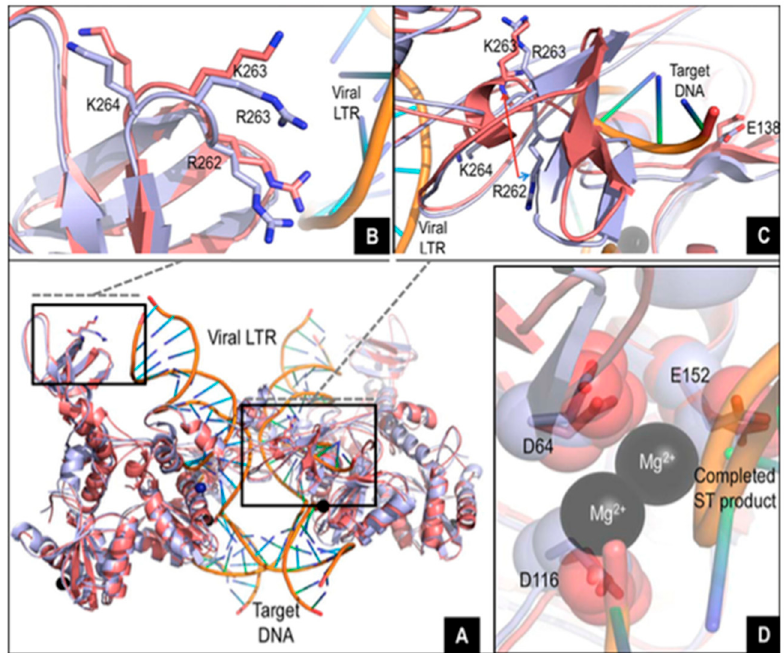
Figure 1. In silico studies of the wild-type and R263K integrases ( A – D ) adapted from Figure 4 of reference [2]. Overlay of the wild-type and R263K integrases, intasome and strand transfer complex models with viral LTR DNA and target DNA. The tetrameric IN structure is composed of the inner and outer subunits; ( B ) Detailed view (8 Å) of the overlay showing proximity between residue 263 in one of the outer subunits and the viral LTR; ( C ) Detailed view (12 Å) showing the pronounced shift in localization and orientation of residue R262 in the presence of the R263K mutation at the vicinity of the target DNA in one of the inner subunits; ( D ) Close-up overlay showing the relative positions of the D 64 D 116 E 152 core catalytic residues in the wild-type and R263K enzymes in the inner subunits.